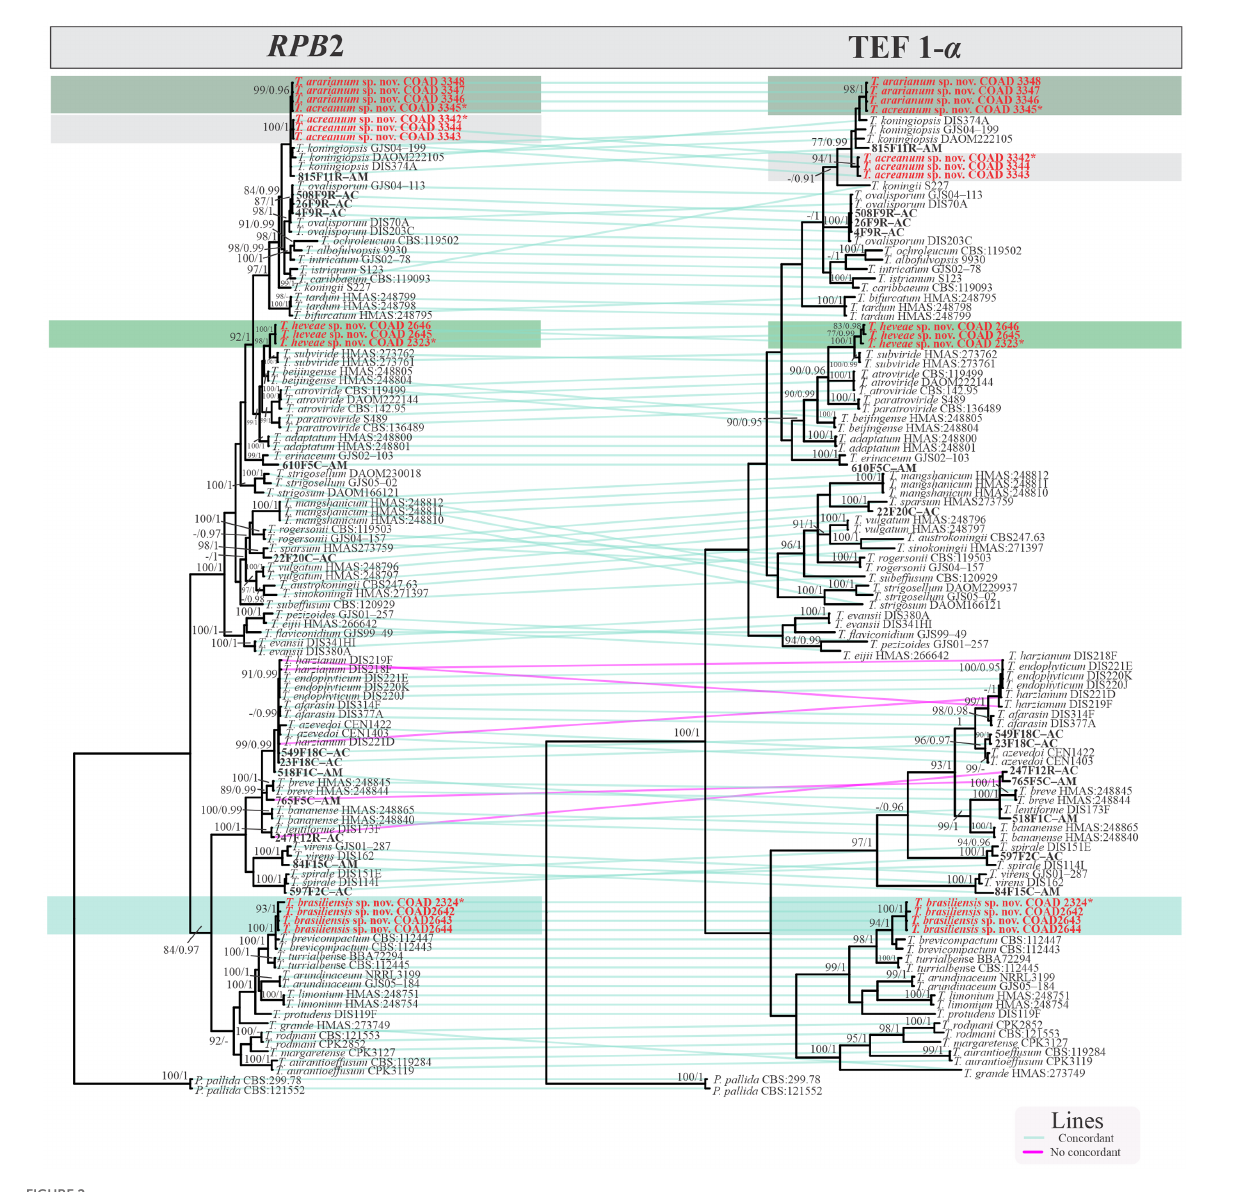
FIGURE 2 Phylogram GCPSR based on TEF1 - α and RPB 2 sequence datasets. Simultaneous analysis of two gene genealogies to show the transition from concordance among branches used to diagnose